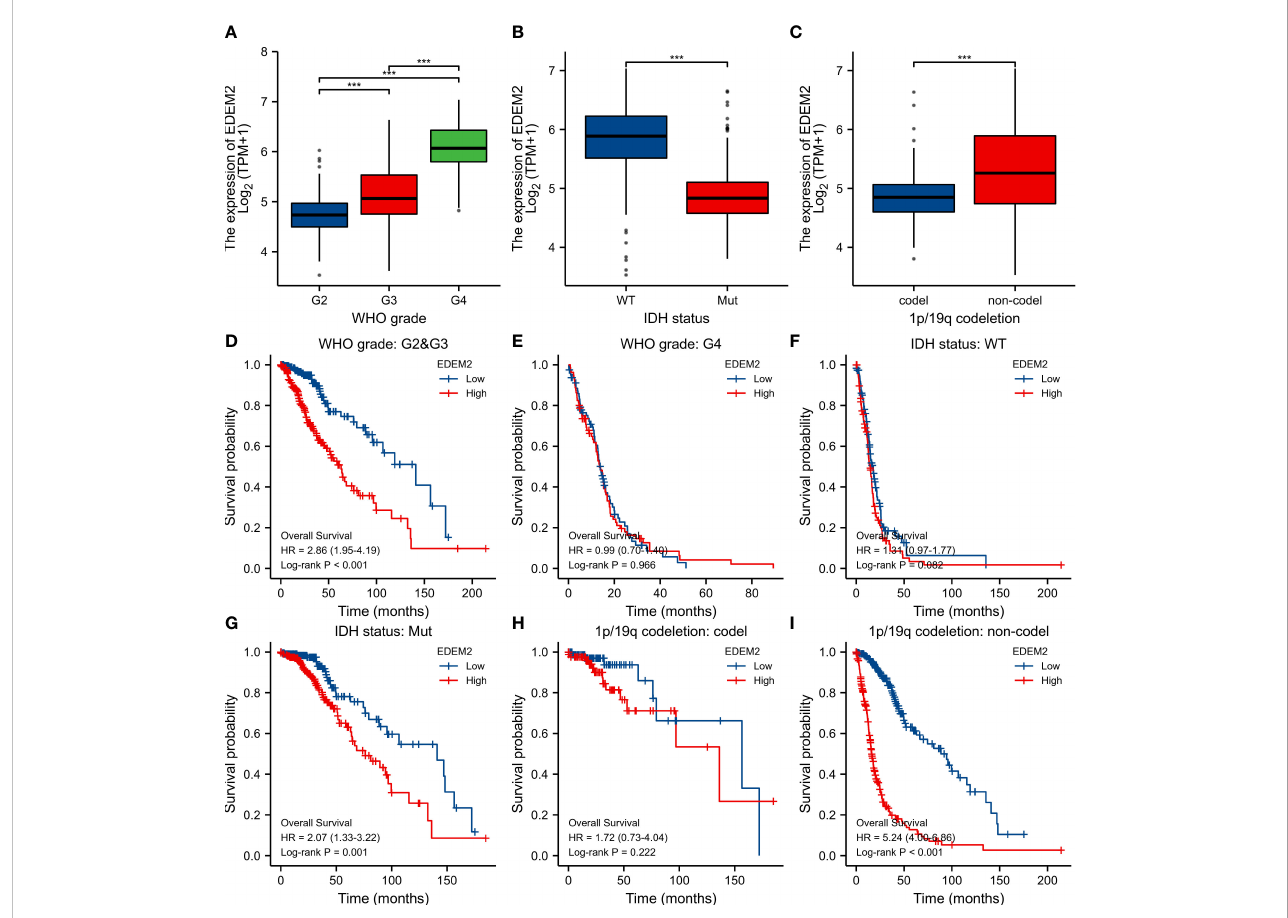
FIGURE 2 Differential expression and survival analysis of subgroups in TCGA cohort. (A-C) EDEM2 expression differences in different pathological conditions, respectively. (D-I) Survival curves for EDEM2 in different pathological states.